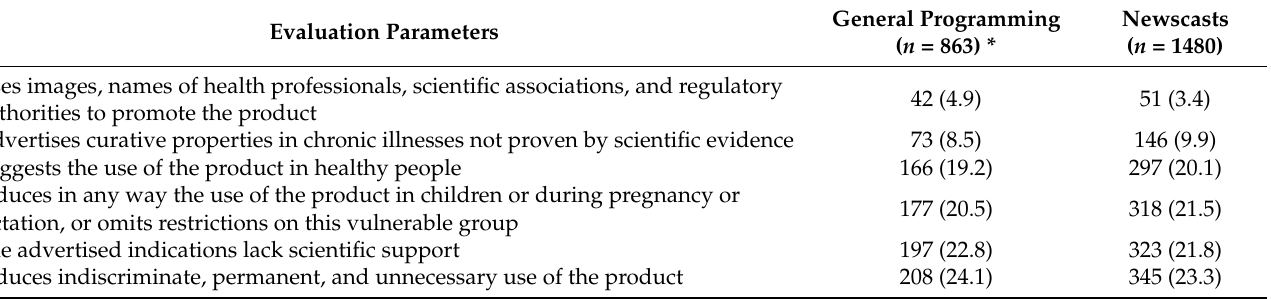
Table 3. Breach of good advertising practices of products for human health, according to broadcast segment on television in Ecuador,